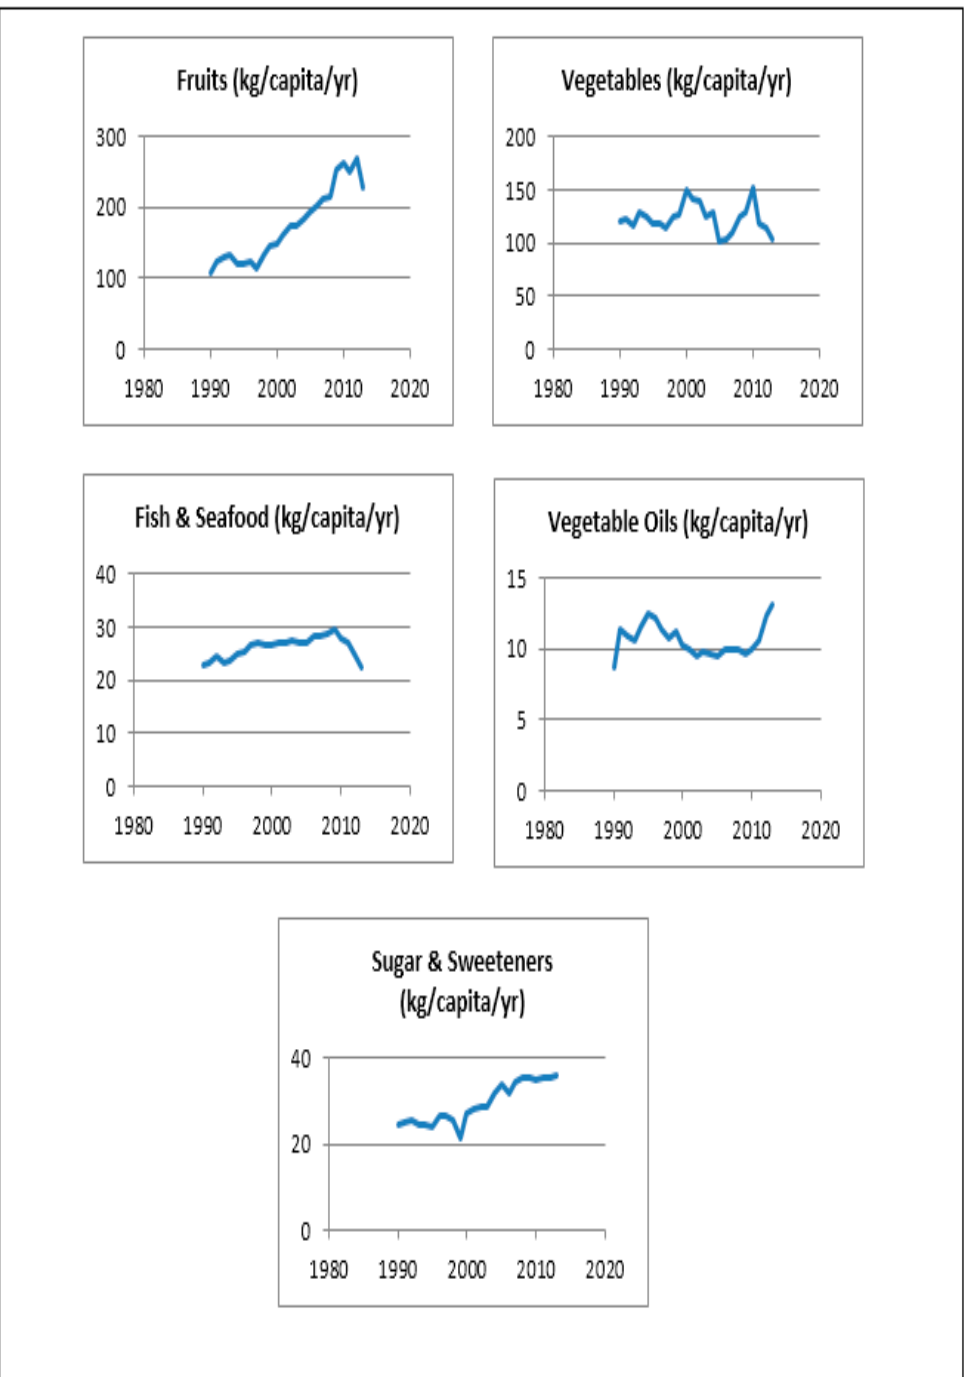
Figure 3. Trend in daily per capita supply (kg) of food groups in Oman. Data from the Food and Agriculture Organization (FAO) food balance sheets, Food and Agriculture Organization Corporate Statistical Database (FAOSTAT) [56] .